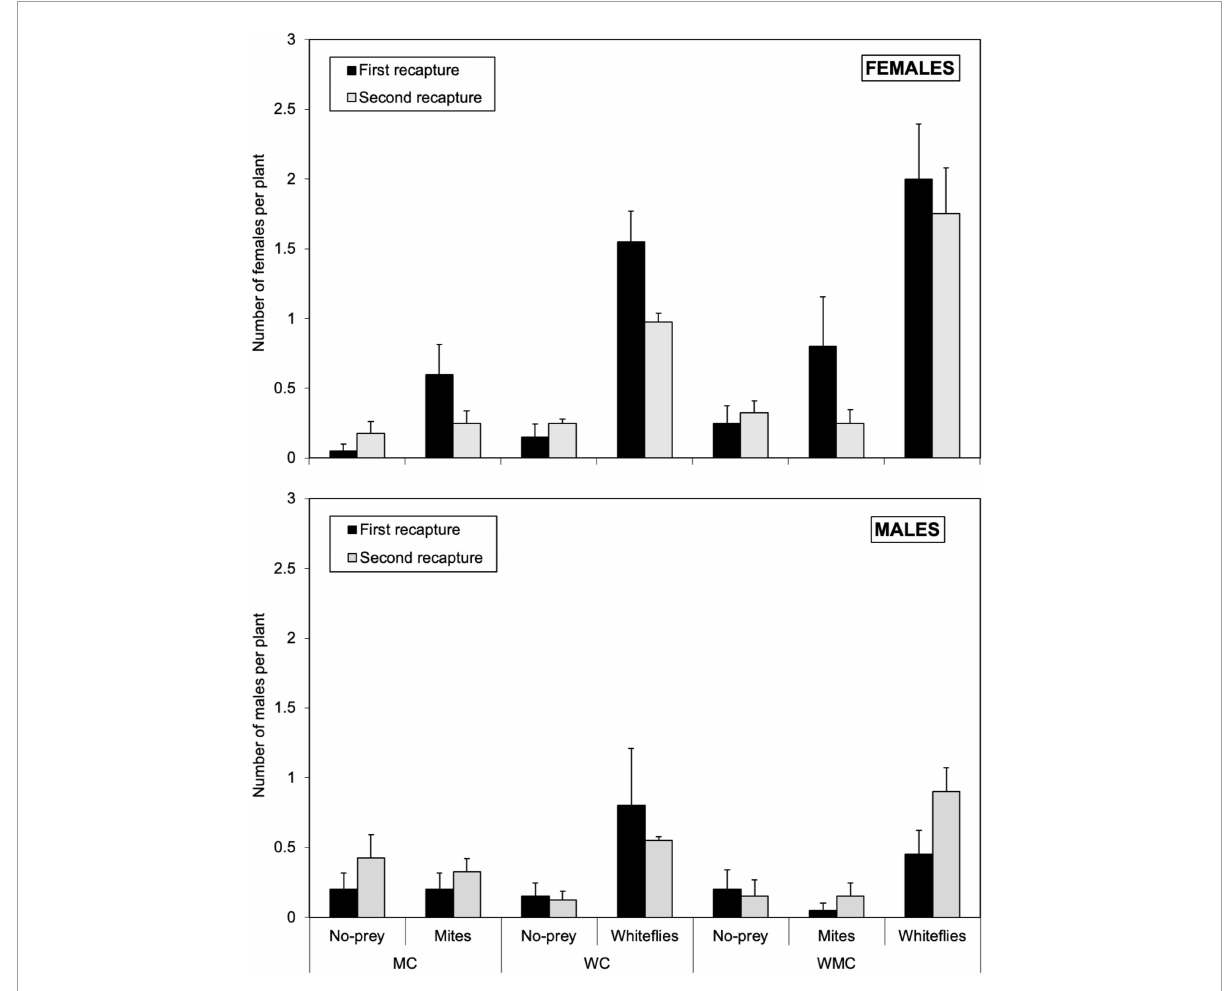
FIGURE1 Average of females (upper graph) and males (lower graph) of D. hesperus per plant with standard errors in the first (5 days after the release) and second recapture (10 days after the release), in three habitats (MC, WC, and WMC) composed by patches with different food resources (No prey- C-, mites- M-,